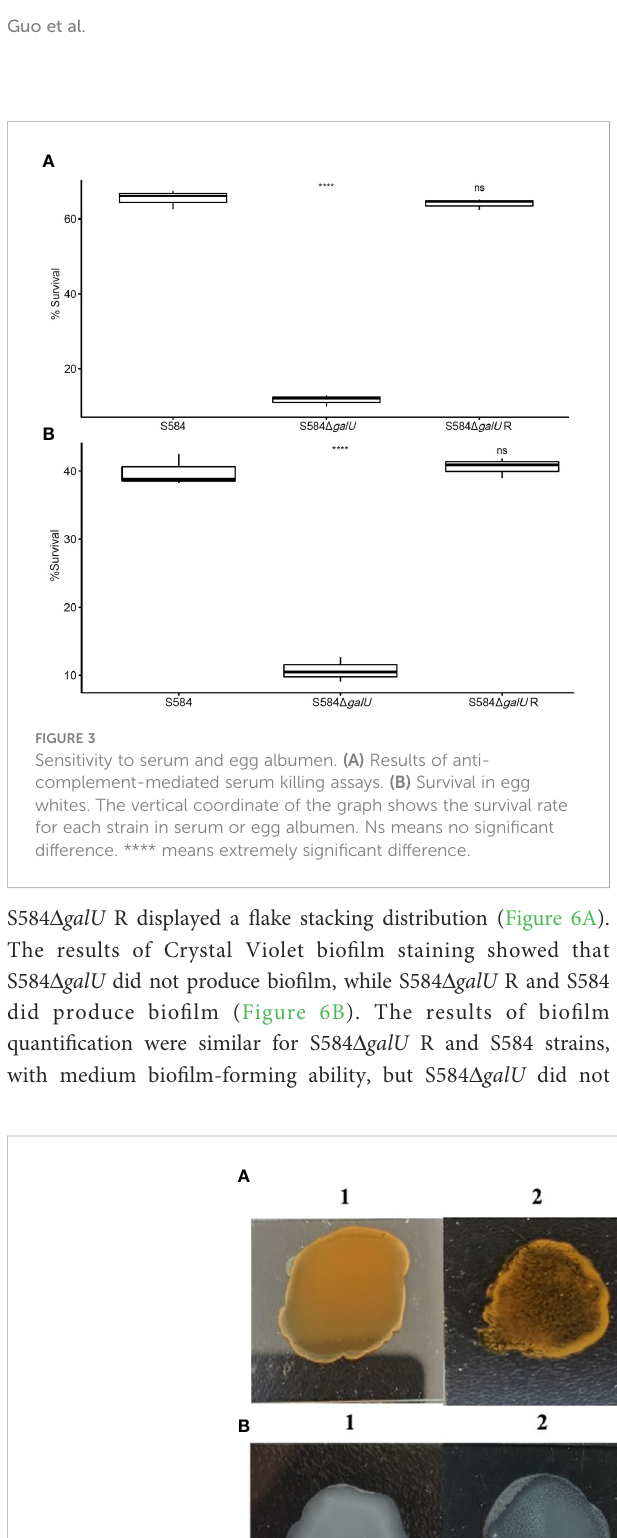
FIGURE 4 Rough phenotype identi fi cation. (A) Results of Acridine Orange agglutination tests. 1, parental strain S584; 2, mutation strain S584 D galU ; 3, complementation strain S584 D galU R; 4, 0.2% Acridine Orange negative control. (B) Salmonella O 9 standard serum agglutination test results. 1, parental strain S584; 2, mutation strain S584 D galU ; 3, complementation strain S584 D galU R; and 4, negative control.